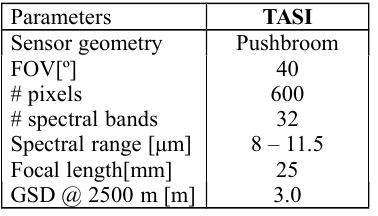
Table 3. TASI main parameters